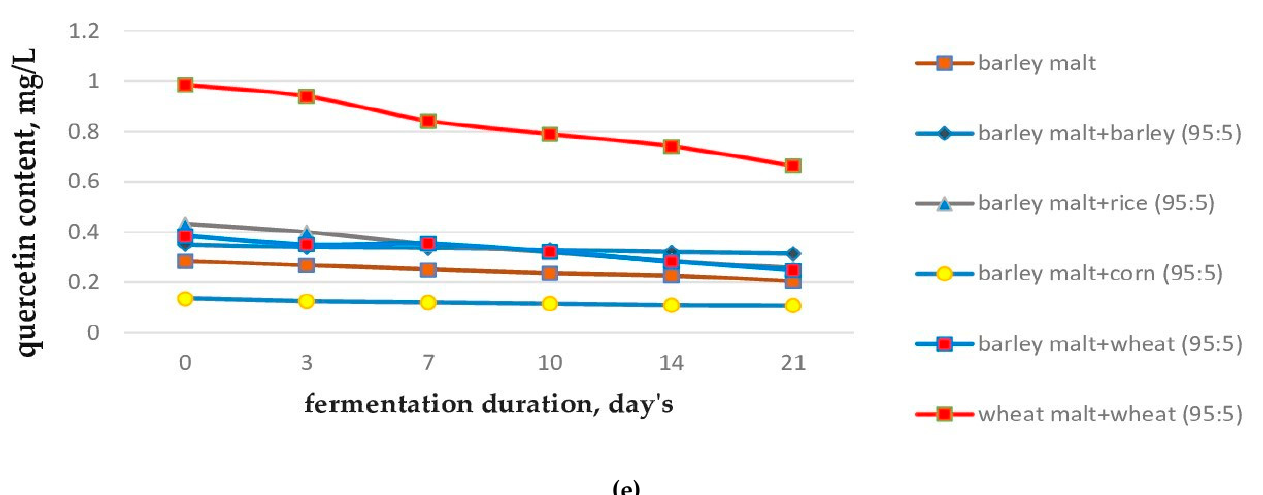
Figure 1. The content of β -glucan ( a ), soluble nitrogen compounds with thiol groups ( b ), catechins ( c ) and iso- α -humulone ( d ), quercetin ( e ), changes in dynamics during wort sample fermentation of different adjuncts.